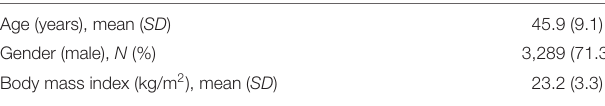
TABLE 2 | Demographic data of the subjects ( N = 4,612).